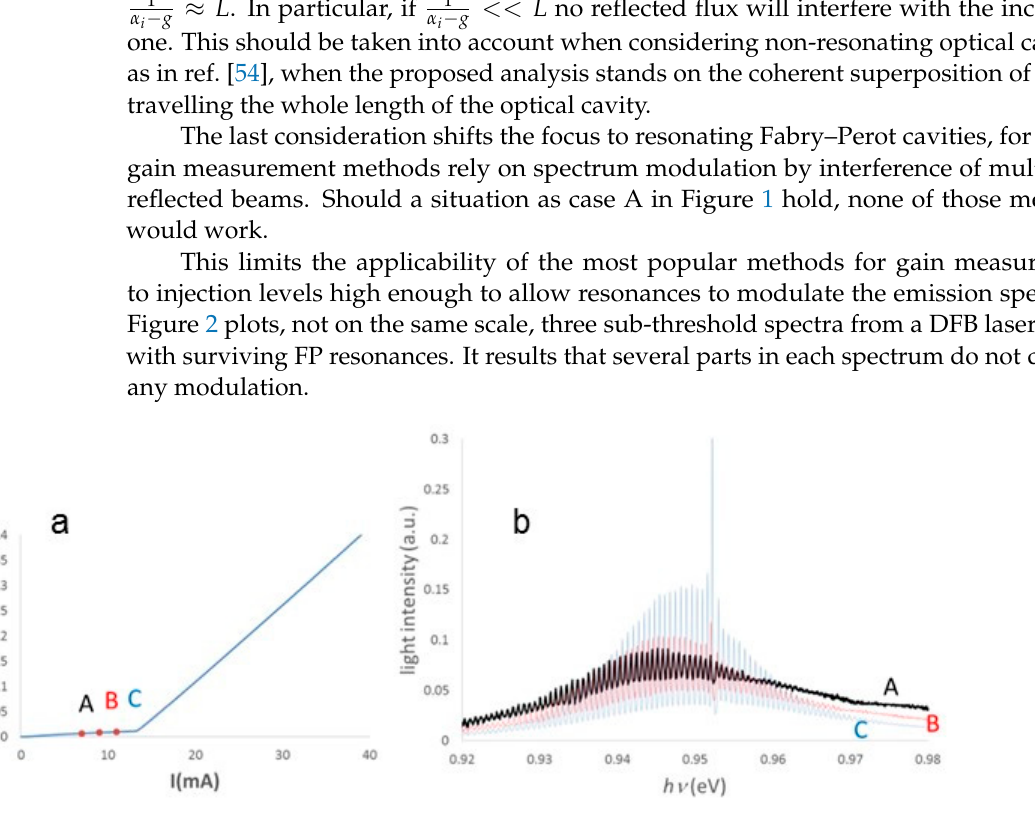
Figure 2. ( a ) Power-current curve of a DFB laser emitting at 1300 nm also with FP resonances; ( b ) spectra measured at 7 mA (A), 9 mA (B), and 11 mA (C), each rescaled in order to appreciate the ratio between baseline and modulation. For all spectra, no resonances appear in the low-intensity range at high photon energy.